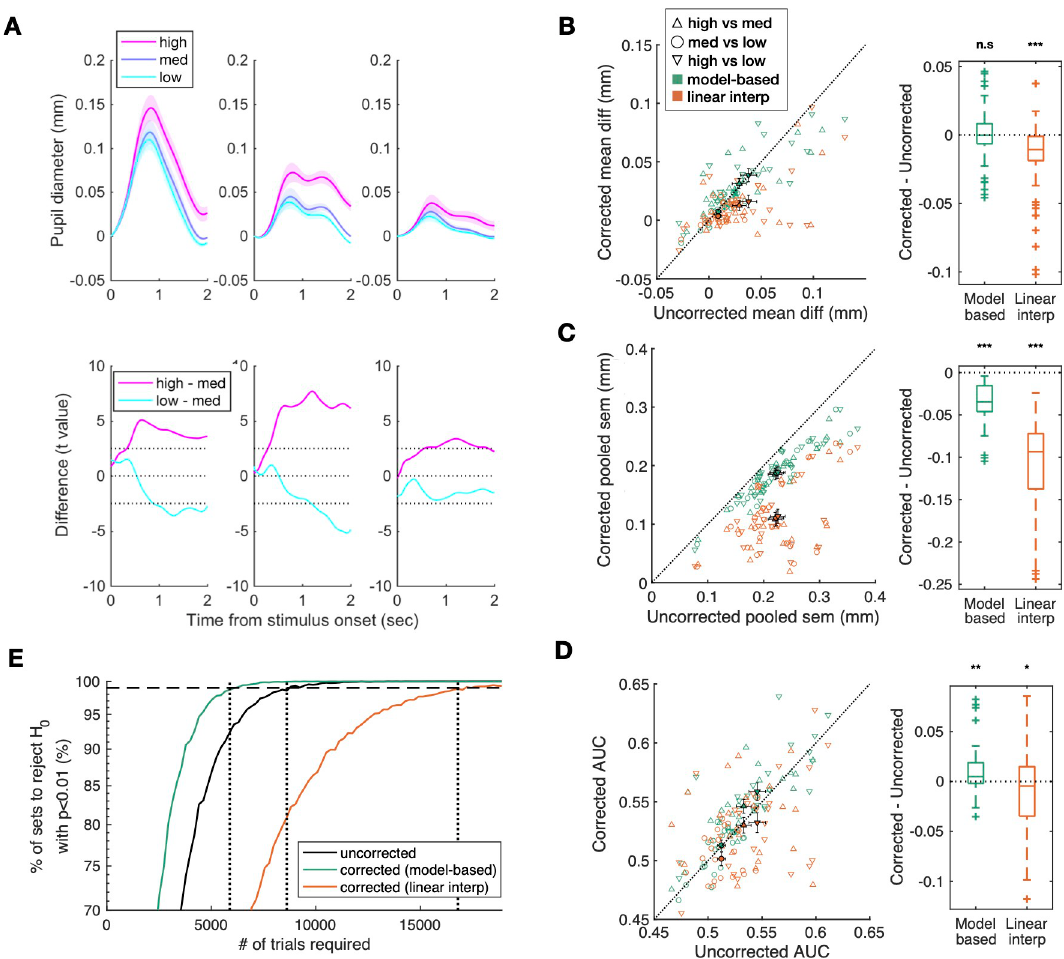
Fig 7. Contribution of BPR correction to the statistical power of the auditory oddball task. ( A ) (top panels) Time courses of pupil size for different levels of sound-frequency oddity. Lines and shades correspond to the means and SEMs across subjects. (bottom panels) Time courses of t statistics (paired t-tests, df = 23) for the deviations of the high oddity (magenta) and low oddity (cyan) conditions from the medium oddity (blue) conditions. The left panel shows the results before correction; the middle and right panels show the results after being corrected using the model-based method and the interpolation method, respectively. ( B-D ) (left panels) Diagonal plot. Each marker indicates each condition pair, a subject has three markers each (high vs medium, medium vs low, and high vs low). Filled marker and error bars indicate the mean and SEM across subjects. Empty markers correspond to individual subjects, with different colors indicating different correction methods (green for the model-based method; orange for the interpolation method) and different symbols indicating different oddity pairs (see inset for detailed labels). (right panels) Boxplot. Corrected–uncorrected, which are equivalents to deviance from the diagonal line in the corresponding left panels. (Wilcoxon signed- rank test, ( � , p < 0.05; �� , p < 0.01; ��� , p < 0.001)). The color scheme matched that shown in the left panels. ( B ) Mean difference in pupil dilation, ( C ) pooled SEM, ( D ) AUC between the conditions. ( E ) Comparison of the data uncorrected (black line), the data corrected with the model-based method (green), and the data corrected with the linear interpolation method (orange) in statistical power. The fraction of significant tests was plotted against the number of trials (see Methods and Materials for the detailed